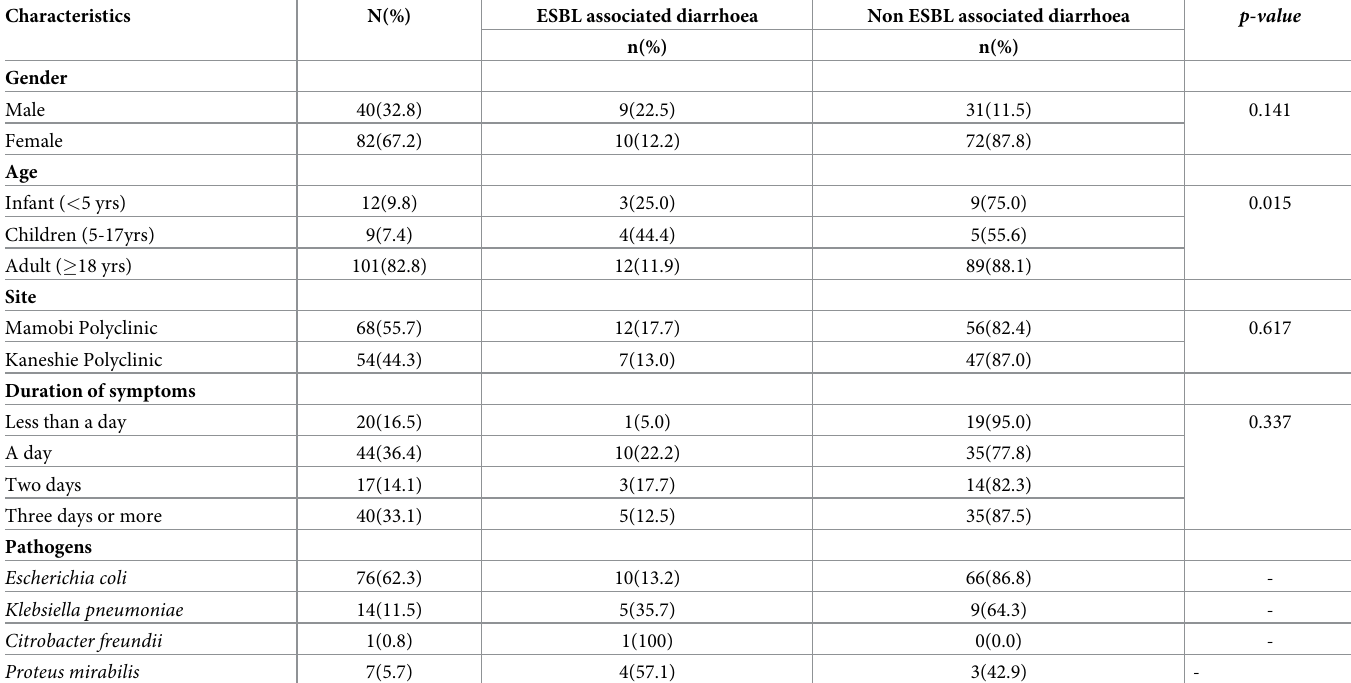
Table 2. The various characteristics of patients versus ESBL associated